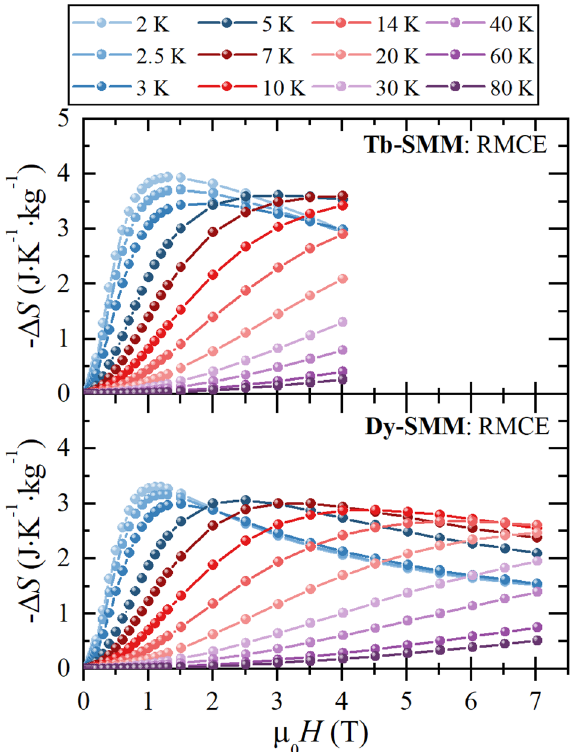
Figure 6. The RMCE entropy change − Δ S ( T , H ) as a function of the magnetic field µ 0 H up to 7 T for the selected temperatures for Tb-SMM and Dy-SMM . Solid lines are guides for the